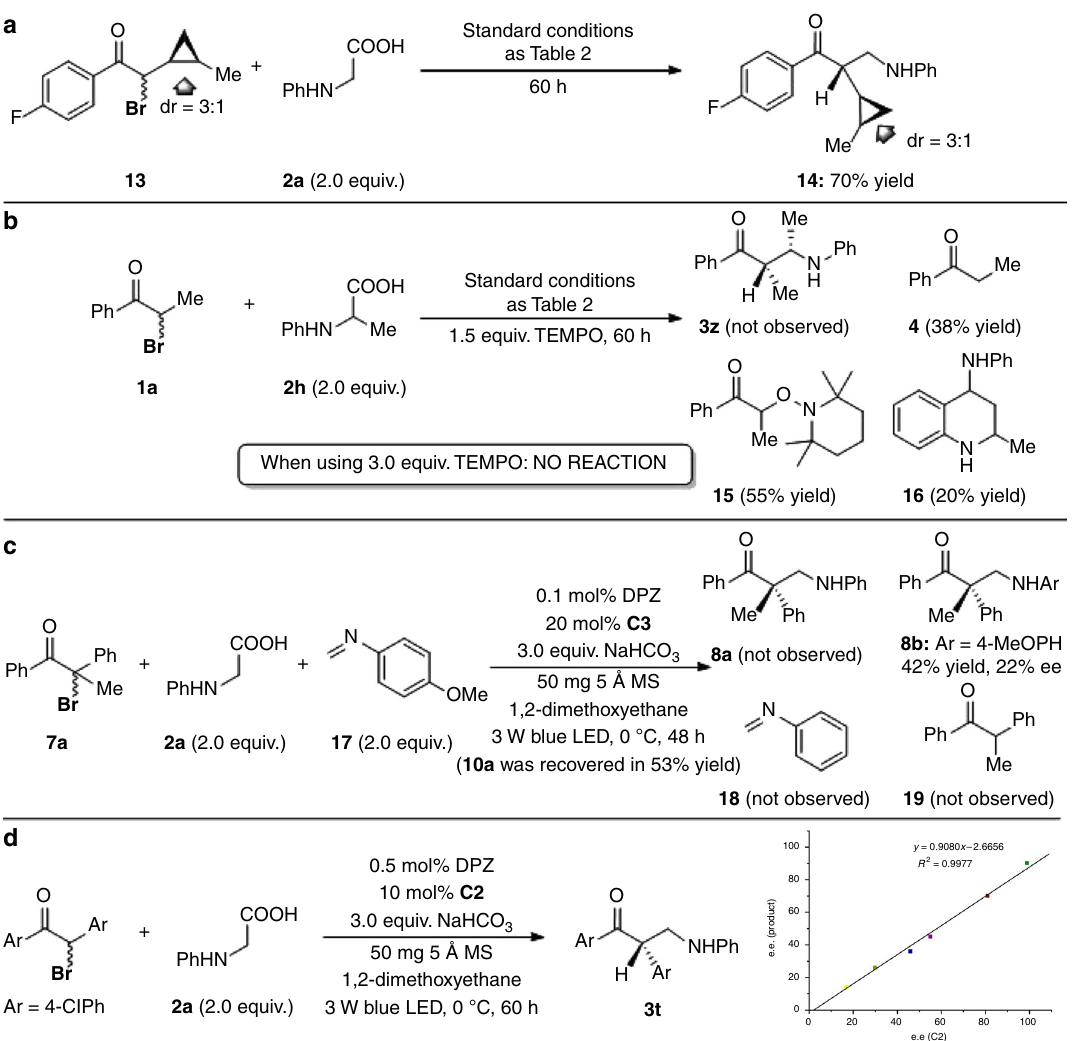
Fig. 6 Experimental studies to elucidate the mechanism. a Radical-clock examination. b Investigation on the effect of TEMPO. c The reaction of bromoketone 7a with N -phenyl glycine 2a and imine 17 . d The study on the relationship between ee of the CPA C2 and ee of the product